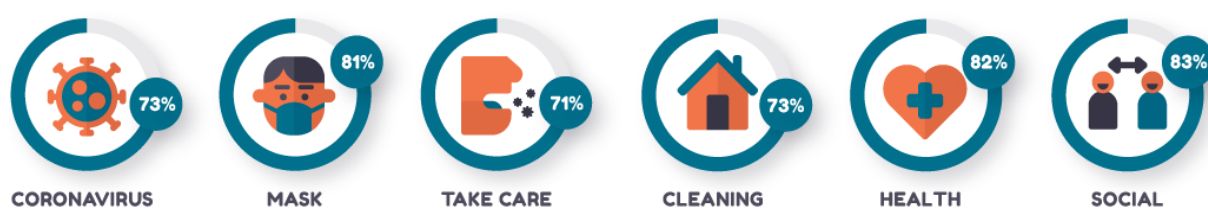
“Mask” ( r =–.83), with a significant correlation ( P =.01). The results for the other topics were not significant.